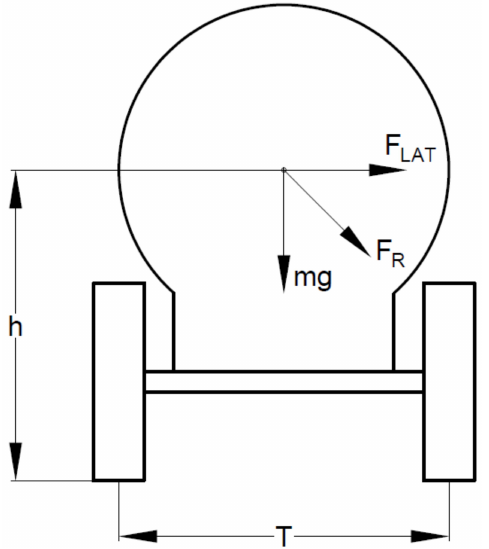
Figure 2. The “quasi-static rigid body”